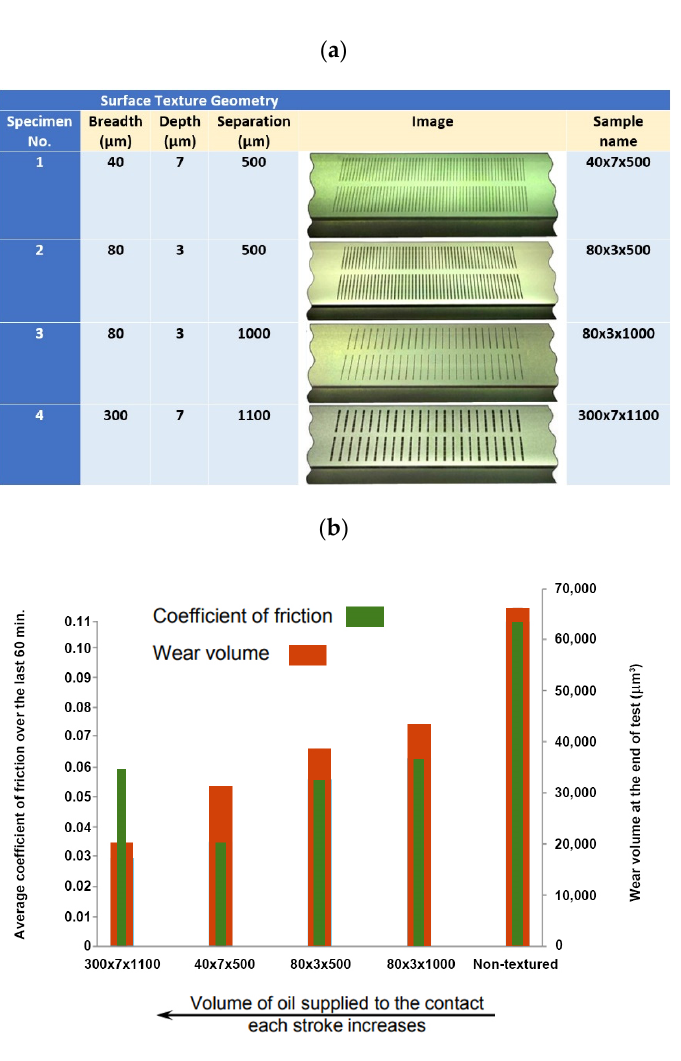
Figure 7. Geometry of texture patterns ( a ), coefficient of friction calculated over the last hour, and final wear for different specimens ( b ), after [73].